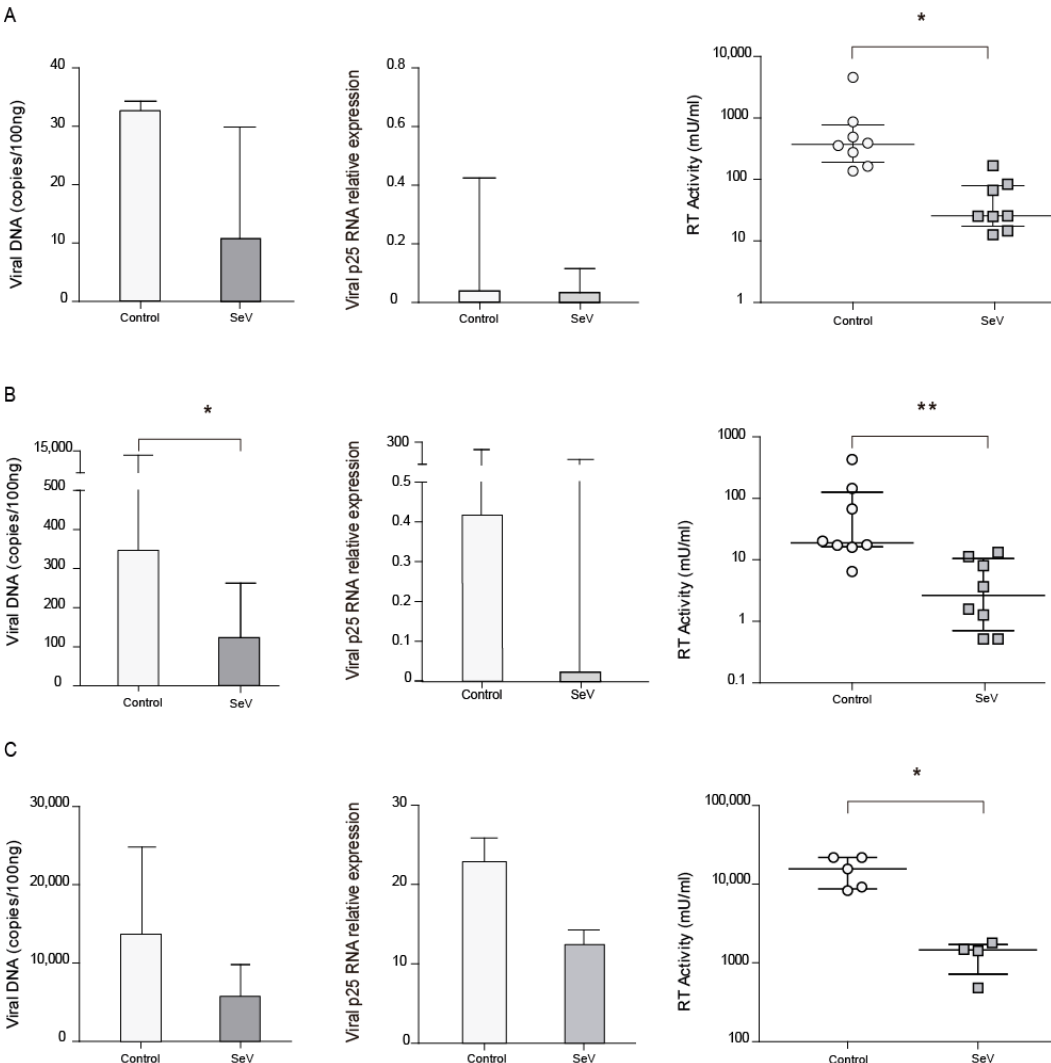
Figure 3. Small ruminant lentivirus (SRLV) replication in ovine cells in the context of SeV. SRLV restriction in ovine alveolar macrophages from chronically infected animals ( A ), or non-SRLV infected animals’ blood derived macrophages ( B ) and skin fibroblasts ( C ) that were mock, or Sendai virus (SeV) infected and challenged later on with SRLV. SRLV viral DNA (left panel), Gag-p25 mRNA relative expression (mid panel), and retrotranscriptase (RT) activity (right panel) was measured in AMs of infected animals or BDMs or OSFs from uninfected animals infected with SeV at an MOI of 10 (grey bars). BDMs and OSFs were further infected with SRLV at an MOI of 0.5 (white bars). Viral DNA was measured at 16 h post-infection, p25 mRNA was measured at 48 h post-infection, and RT activity was measured by SYBR Green based real time PCR enhanced reverse transcriptase assay (SG-PERT) in clarified supernatants at 72 h post-infection. Data shown are the median (±interquartile range) and differences were analyzed using the Wilcoxon paired test (* p < 0.05, **p < 0.01). 3.5. Ovine Cells Infected with SeV-GFP Inhibit HIV-1-GFP Vector Infectivity Beyond SRLV, the antiviral state induced in ovine cells after SeV infection may also affect the infectivity of heterologous lentiviruses such as HIV. VSV-G pseudotyped HIV-1-GFP vector infectivity could be analyzed in OSF and BDM by qPCR of the recombinant HIV-derived GFP